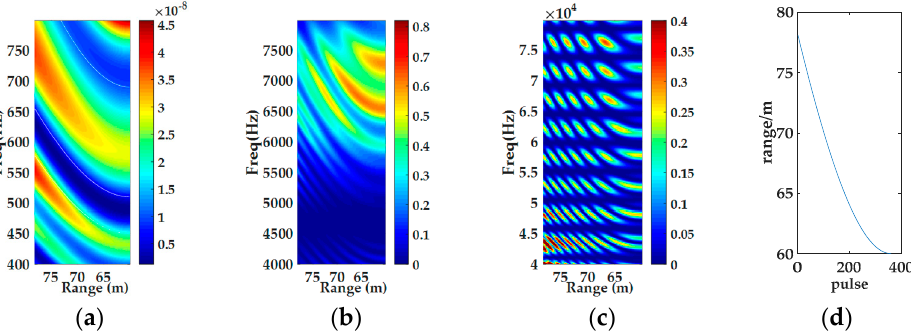
Figure 4. The simulation results in the bistatic configuration: ( a ) the interference pattern for 400 − 800 Hz; ( b ) the interference pattern for 4 − 8 kHz; ( c ) the interference pattern for 40 − 80 kHz; ( d ) the motion trajectory.